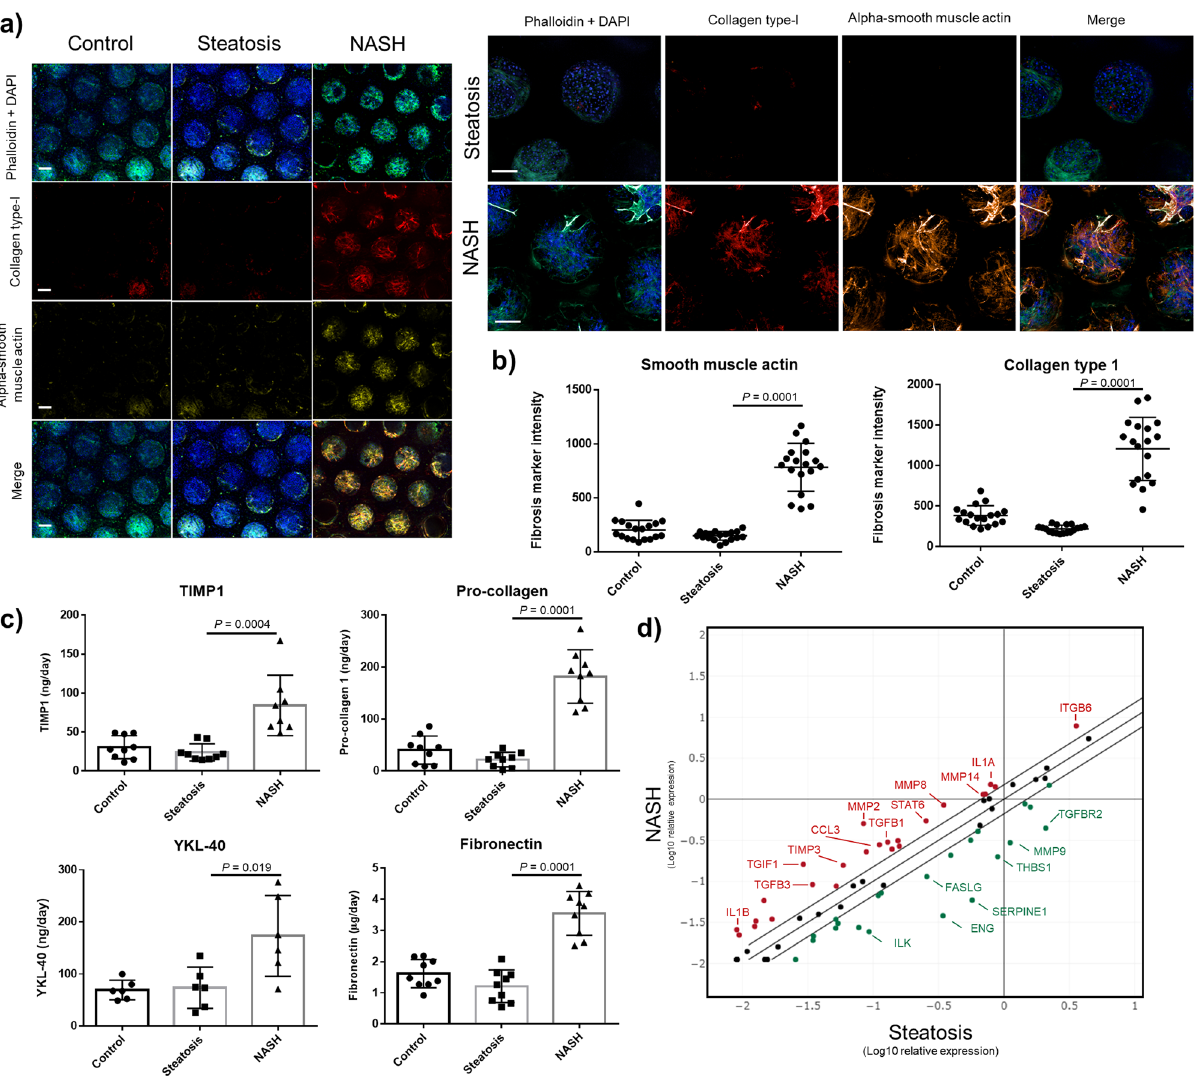
Fig. 1 Liver MPS NASH model demonstrates fi brotic phenotype. PHH alone (Control and Steatosis) or PHH, KC and HSC co-cultures (NASH) were cultured in the MPS platform for 14 days under standard media (control) or high fat conditions (Steatosis and NASH). a Liver microtissues were stained for cytoskeleton (phalloidin), collagen-type I and α -SMA and imaged by confocal microscopy. Representative images shown and scale bars 200 µ m. b Staining of microtissue was quanti fi ed by measuring total fl uorescence intensity throughout individual microtissues, each data point represents an average of all microtissues within a FOV (min 8, max 12) and two FOV per scaffold. c Secreted fi brosis biomarkers TIMP-1, Pro-collagen 1, YKL-40 and Fibronectin were all measured in cell culture medium by ELISA, at the end of the culture. d The expression of fi brosis genes was analysed in total RNA from steatosis and NASH models using Human Fibrosis RT2 Pro fi ler PCR Arrays. Gene expression levels are expressed as Log10 relative expression compared to housekeeping genes (GAPDH/B2M/HPRT1) and compared between the NASH and steatosis models (red = upregulation, green = downregulation, black = no change, upper line — 1.5-fold increase, lower line 1.5-fold decrease). All data points shown with means ± SD highlighted, data generated from a minimum of nine independent cultures (three donors per condition and n = 3 per